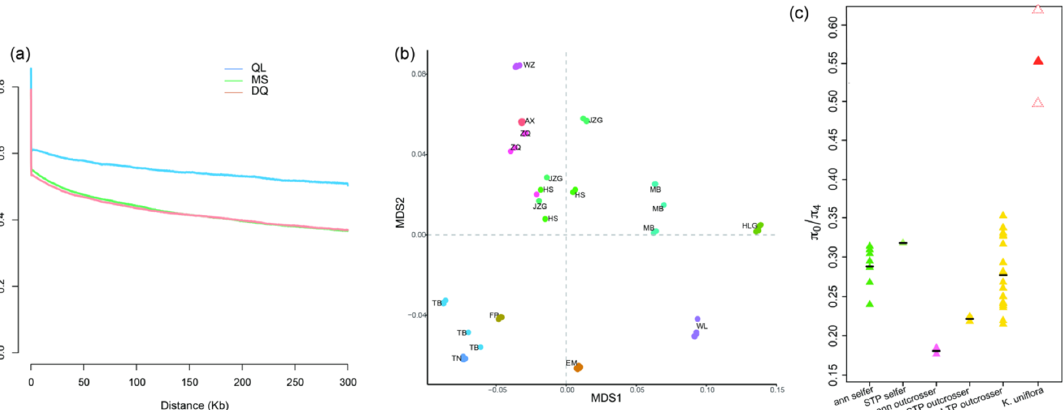
Figure 4. Analyses of genetic signatures expected under asexuality. ( a ) Decay of linkage disequilib ‐ rium (LD) with physical distance in three genetic groups of Kingdonia uniflora . Averages of pairwise linkage disequilibrium measures r 2 are plotted for each bin of distances between pairs of SNPs. The displayed data are for the bins with pairs of SNPs separated by ≤ 300 kb. ( b ) Multidimensional scal ‐ ing analysis of identity ‐ by ‐ state pairwise distances between individuals. Individuals in the same population are coded with the same color. Individuals that come from the same population and cluster together are grouped into one genotypic group, and a total of 24 genotypic groups are iden ‐ tified. ( c ) π 0 / π 4 difference between K. uniflora and other plants reported in Chen et al. (2017) [43]. The figure is modified based on Figure 2B in Chen et al. (2017) [43]. STP, short ‐ term perennial; LTP, long ‐ term perennial. The red triangle shows the average value of π 0 / π 4 in K. uniflora ; the triangles with dashed lines show the range of π 0 / π 4 values in K. uniflora .